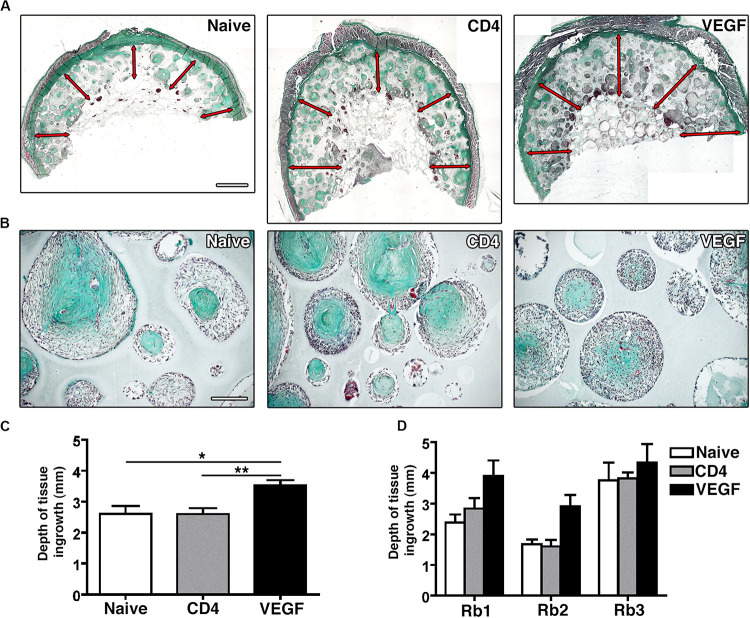
(A) Representative macroscopic pictures of graft sections stained with Masson’s Trichome. Red arrows indicate tissue invasion (size bar = 2 mm). (B) Representative pictures of scaffold pores containing collagenous dense matrix (Masson’s trichrome staining, size bar = 100 μm). (C) Quantification of the average depth of tissue ingrowth for the 3 conditions (n = 3, *p < 0.05, **p < 0.01). (D) Quantification of the depth of tissue ingrowth for the three individual rabbits (Rb1-3) included in the overall analysis in panel (C).